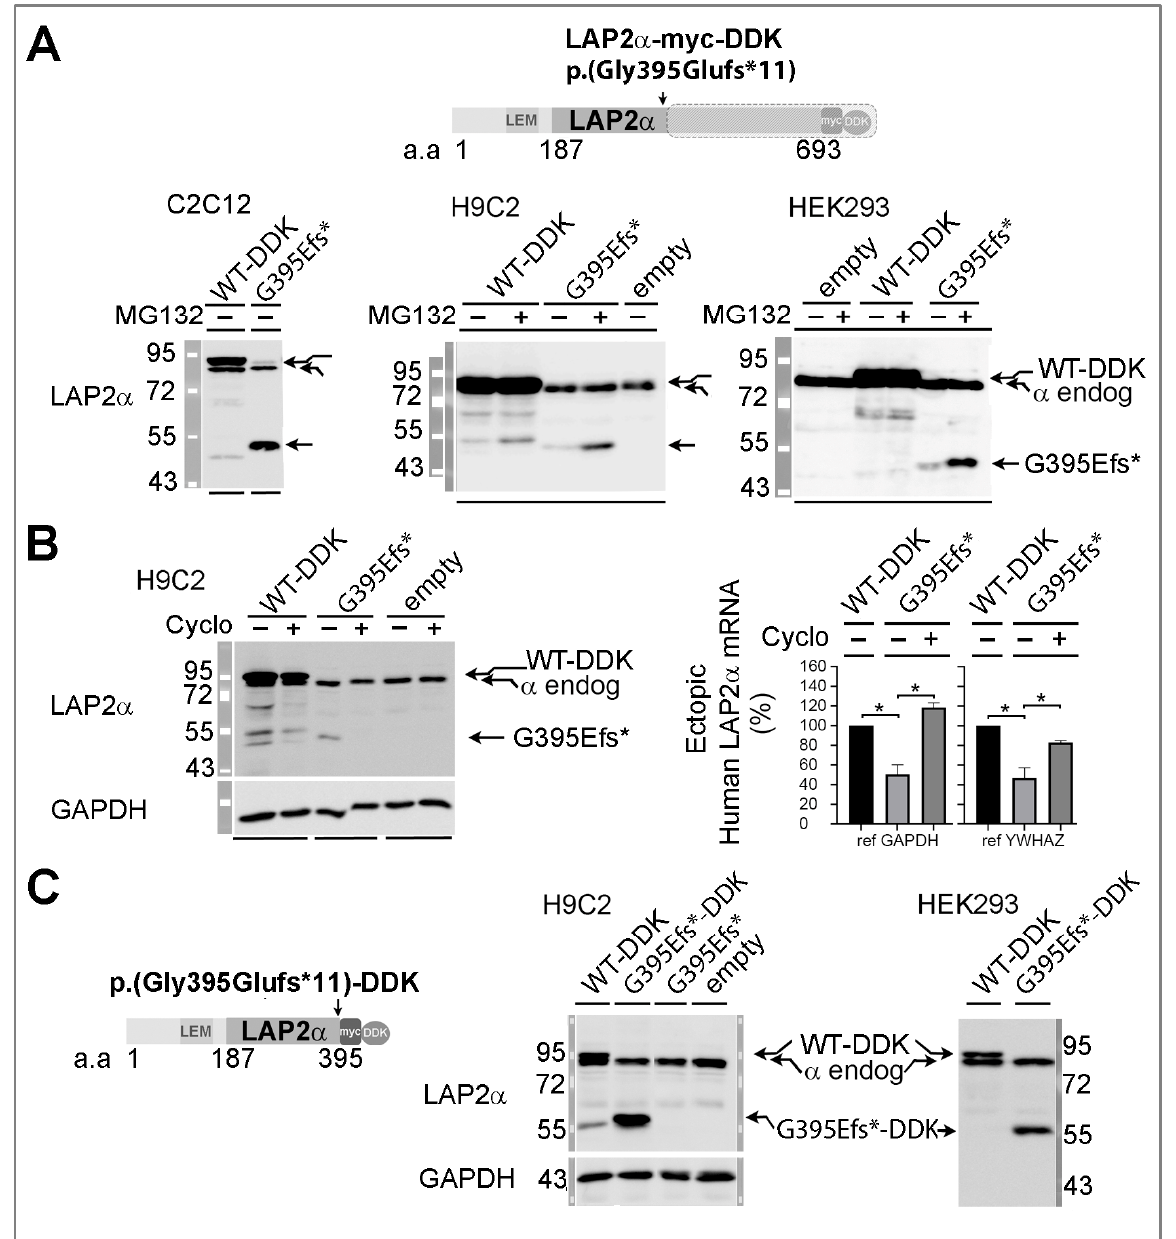
Figure 4. Expression levels of full-length and truncated LAP2 α in cells. ( A ) Schematic secondary structure of exogenous p.(Gly395Glufs*11) (G395Efs*) LAP2 α (Top panel). LAP2 α Western blot on whole cell extracts of C2C12 cells, H9C2 cells or HEK293 cells overexpressing either wild-type (WT-DDK) or mutant (G395Efs*) LAP2 α or transfected with an empty vector (empty). Cells were pre-incubated with (+) or without ( − ) 20 µ M MG132 for 3h, as indicated. ( B ) H9C2 rat cells overexpressing WT or G395Efs* LAP2 α were pre-incubated (+) or not ( − ) with 100 µ g/mL cycloheximide (Cyclo) for 6h; Western blot (left) and ectopic LAP2 α mRNA quantification (right). The graphs show the mRNA amount (relative to WT; mean ± s.e.m.) of ectopic human LAP2 α (n = 6 experiments); GAPDH or YWHAZ was used as a reference gene, as indicated. * p < 0.05. ( C ) Schematic secondary structure of exogenous p.(Gly395Glufs*11-DDK) (G395Efs*-DDK) LAP2 α proteins (Left panel); for suppressing NMD, the original mutated sequence around G395 was kept and followed immediately by the DDK tag. LAP2 α Western blot on whole extracts of H9C2 cells or HEK293 cells overexpressing WT-DDK, G395Efs*-DDK or G395Efs* LAP2 α proteins; with GAPDH used as a reference protein.